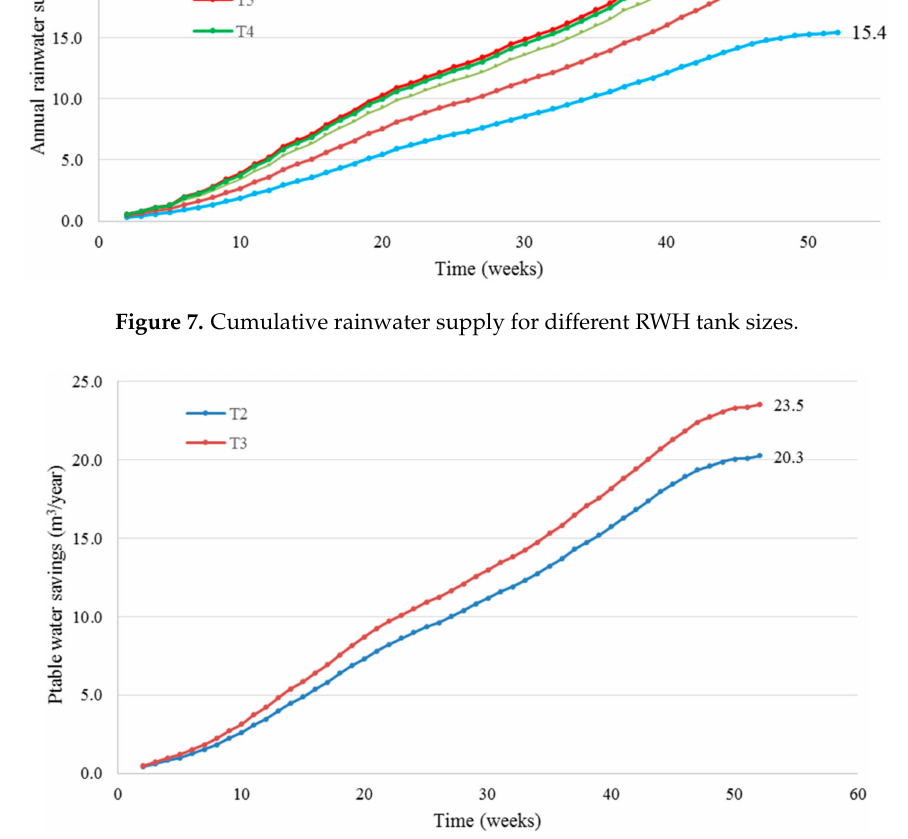
Figure 8. Annual potable water savings (volume) for various tank sizes and system alternatives (T2, T3, Alt 2, Alt 3). Table 3. Initial investment costs of the proposed